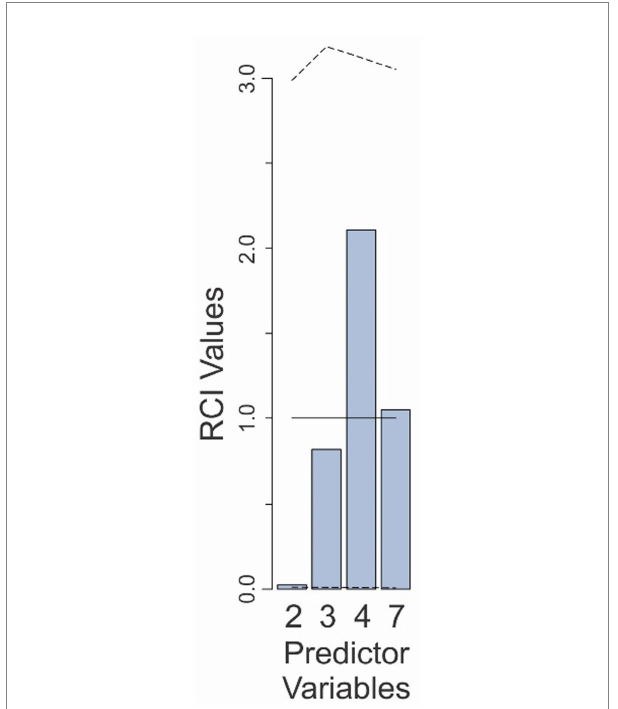
FIGURE 4 Relative contributions of various predictors to the fit of the Final Model in Experiment 2. The predictor variables are those that are retained in the Final Model and are numbered as in Table 2. The solid line denotes the expected contributions of the various predictors. The dashed lines denote the upper and lower 95% confidence intervals (uncorrected), empirically determined from the data. See text for